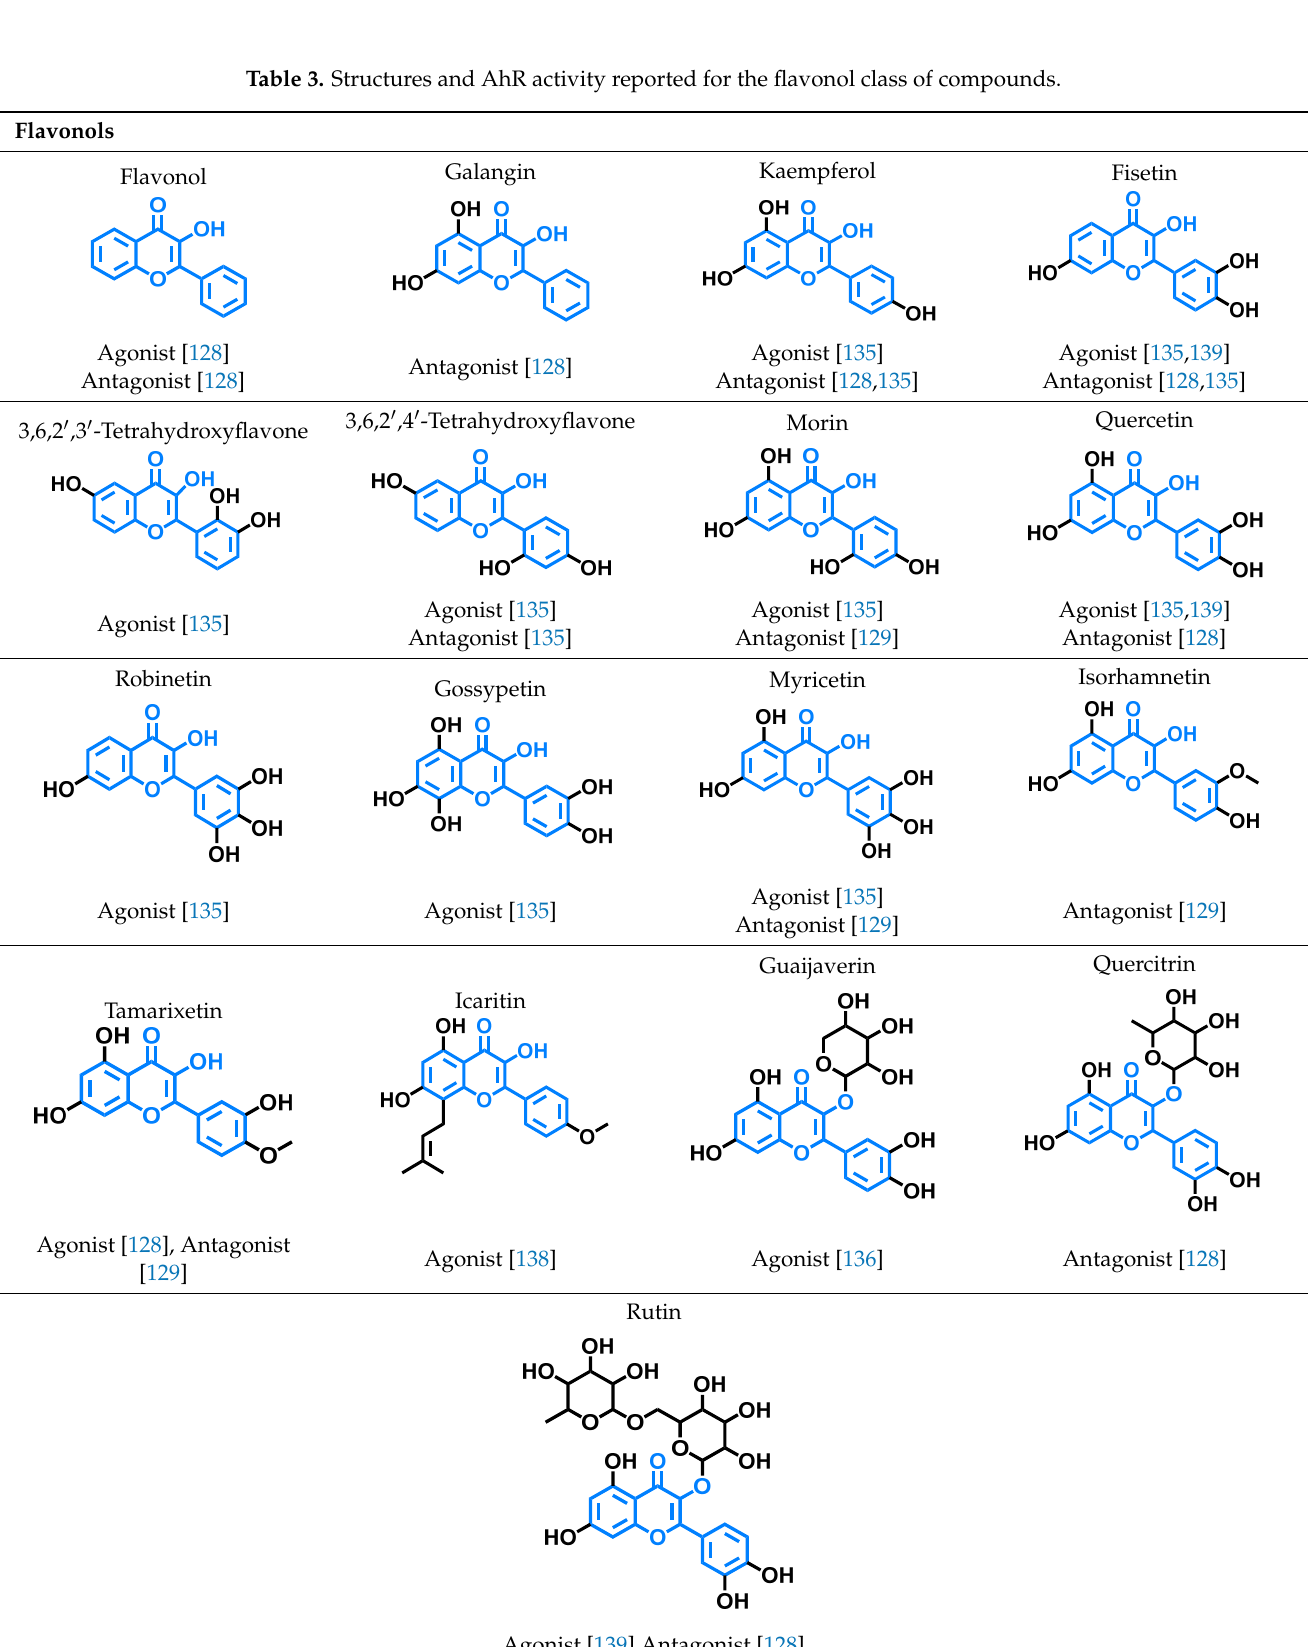
Table 4. Structures and AhR activity reported for the flavanone class of compounds.